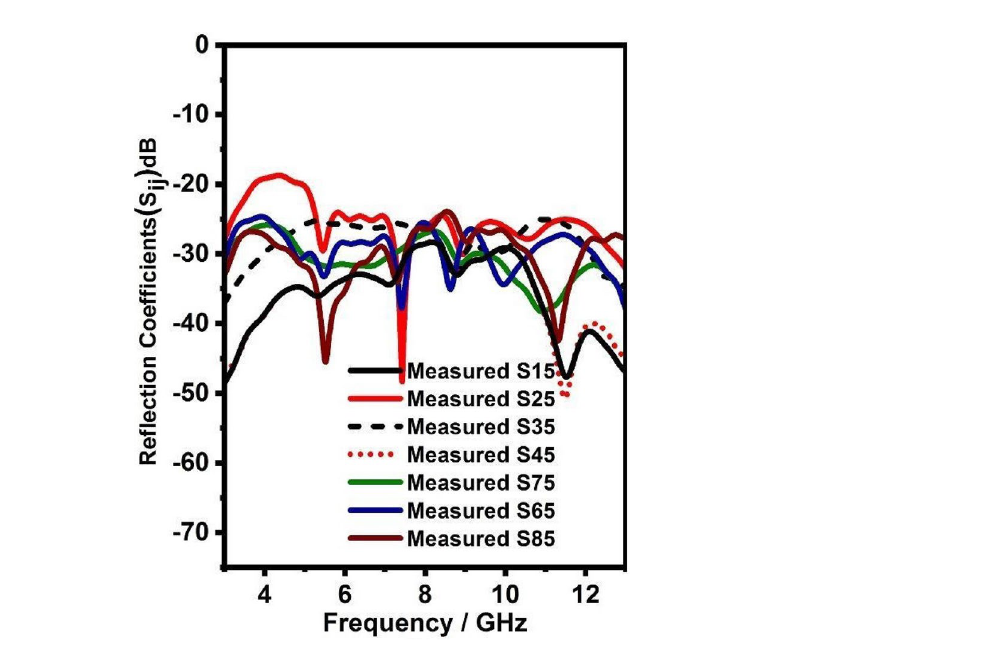
Figure 16. Mutual coupling (Measured) of integrated antenna